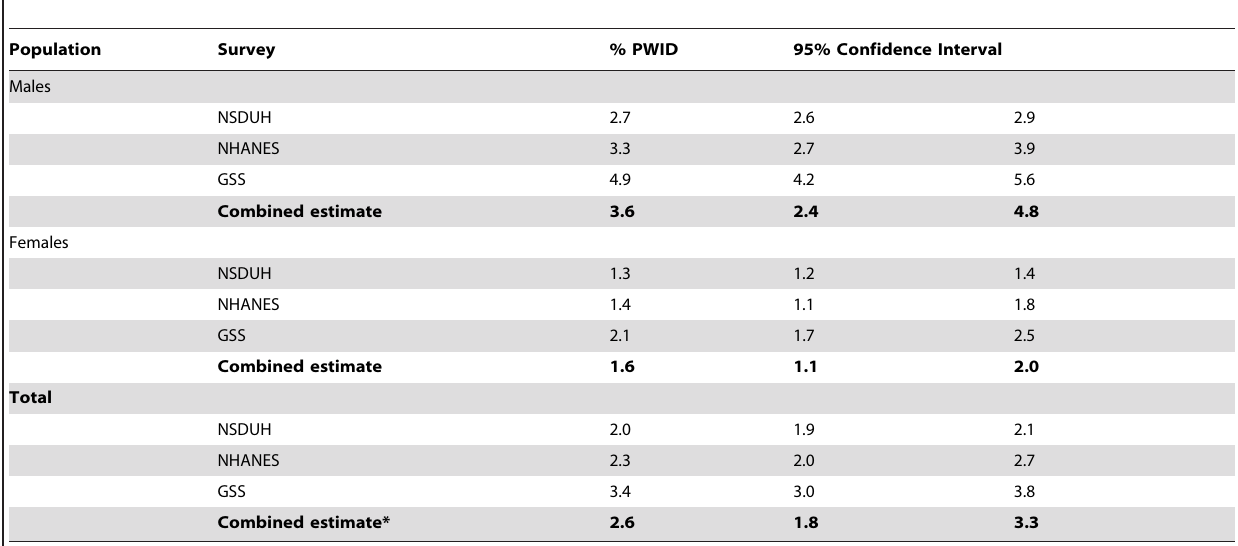
Table 2. Estimated proportion of persons who injected drugs (PWID) in their lifetime, by survey and combined by meta-analysis, United States.